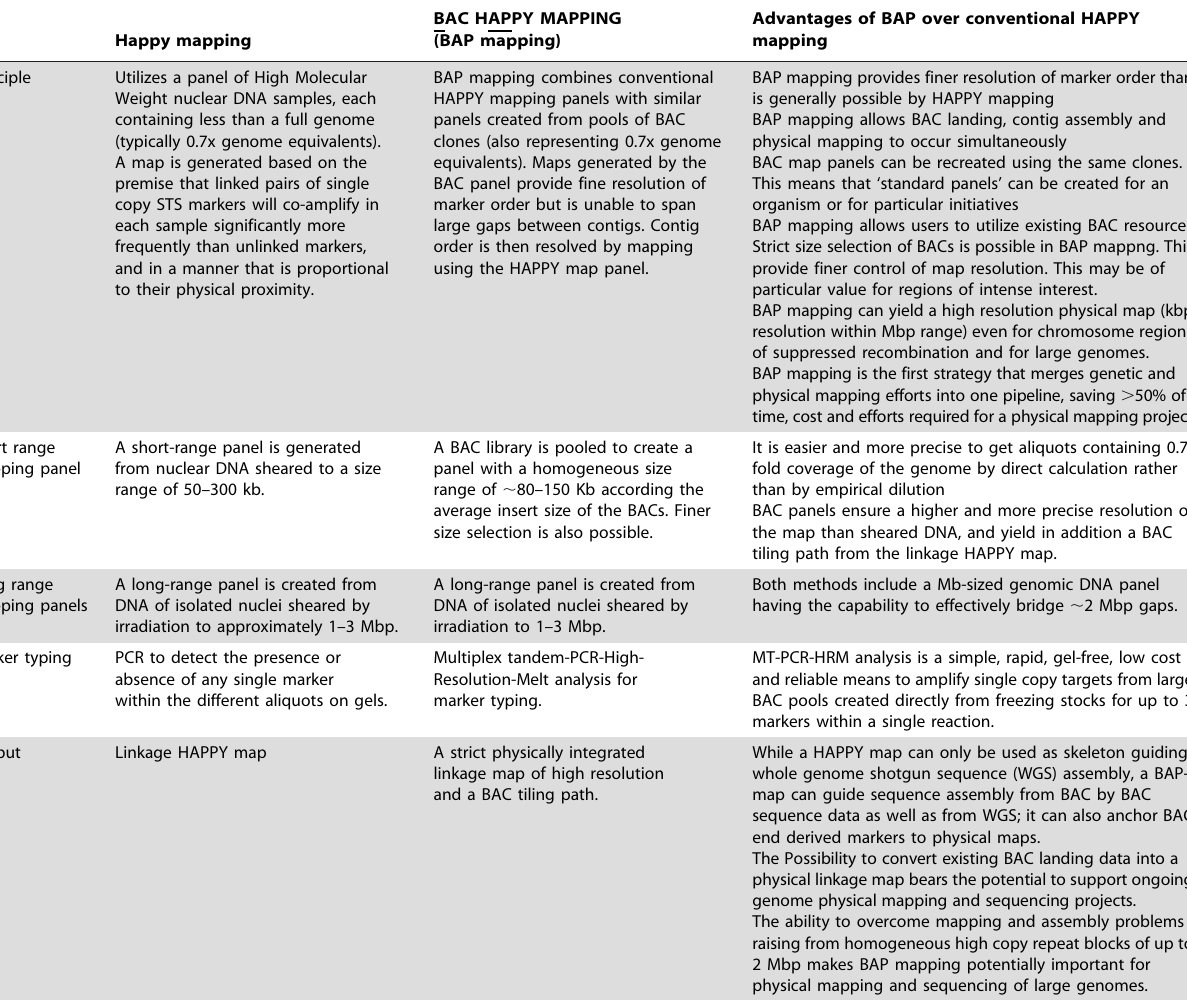
Table 1. Comparison of BAP mapping and conventional HAPPY mapping.